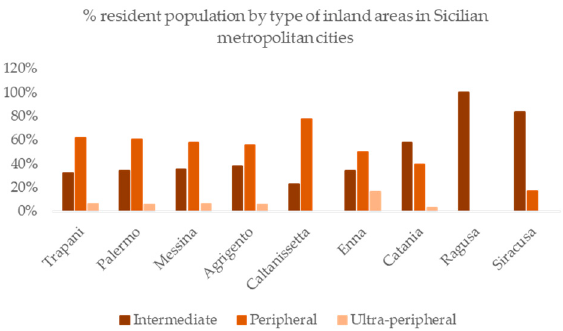
Figure 7. Percentage of resident population by type of inland areas in Sicilian metropolitan cities. (Authors’ elaboration from NSIA data.)